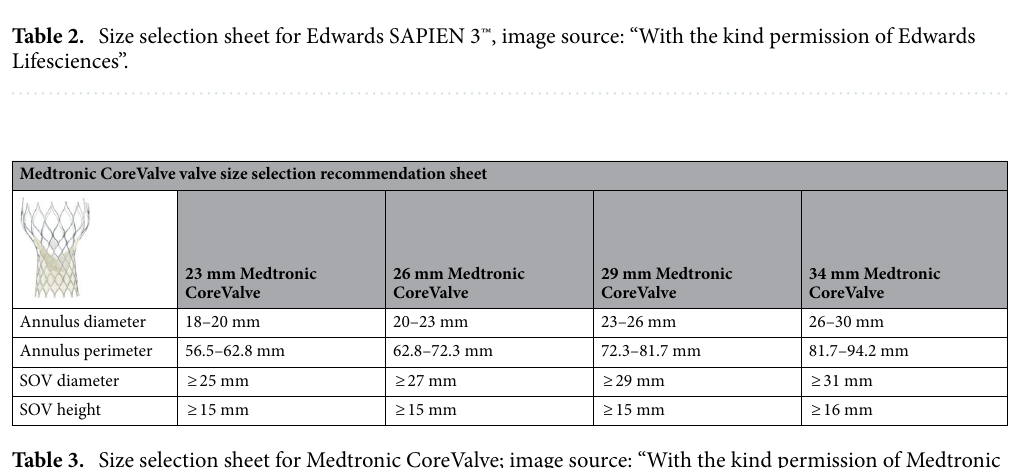
Table 3. Size selection sheet for Medtronic CoreValve; image source: “With the kind permission of Medtronic GmbH”.